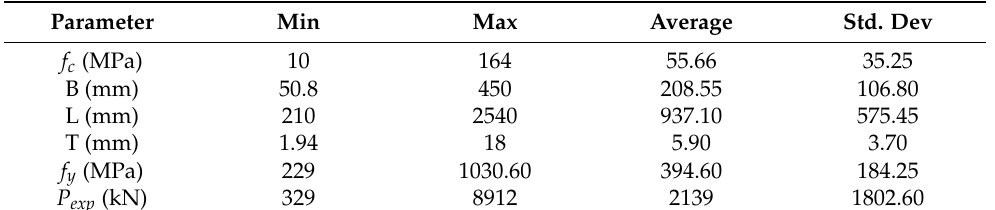
Table 1. Statistical distribution of data.